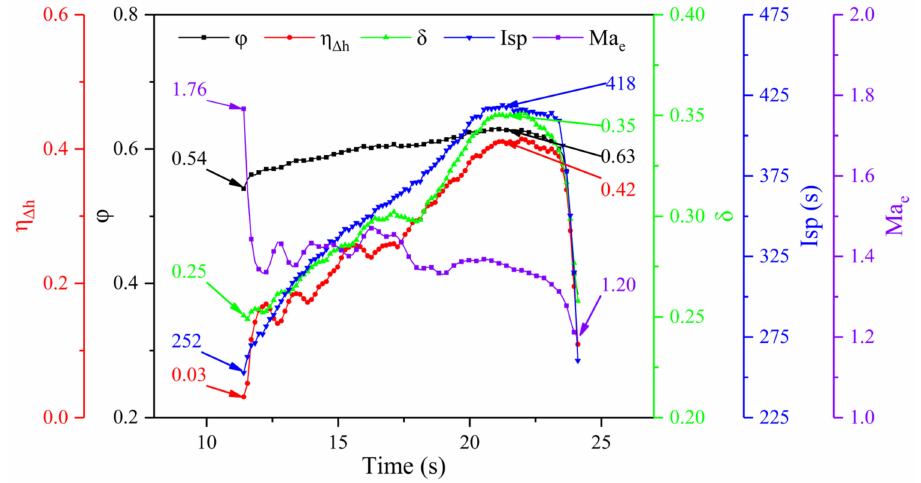
Figure 19. Evolution of the solid scramjet performance parameters during the test. Both the combustion efficiency and the total pressure recovery coefficient increased, the latter from 0.25 to 0.35. This is contrary to the results of previous studies, which suggest that the higher the combustion efficiency, the smaller the total pressure recovery